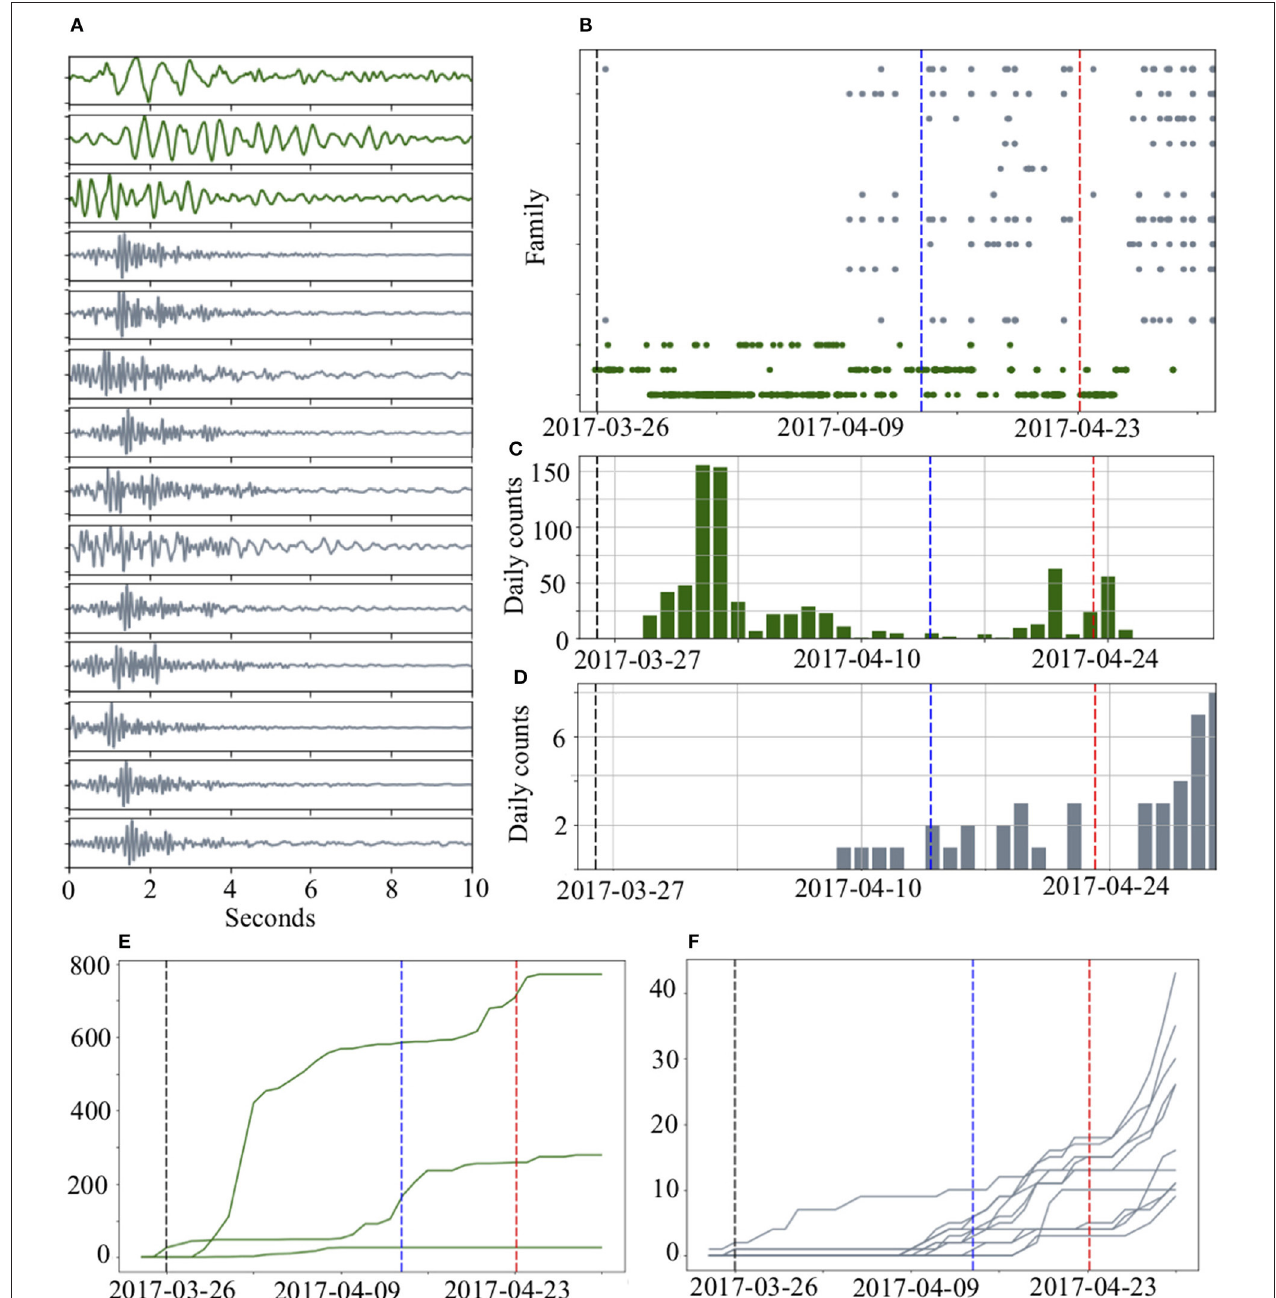
FIGURE 4 | (A) Core events (normalized) of each family identified by REDPy. VT events are shown in gray, LF events in green. (B) Duration of families, colored with respect to (A) . (C) Daily count of dominant LF family (greatest number of events) corresponding to the first waveform in (A) identified by template matching technique (EQcorrscan). (D) Daily counts of dominant VT family (greatest number of events) identified by template matching technique (EQcorrscan). (E) Cumulative counts of earthquakes within each LF family. (F) Cumulative counts of earthquakes within VT families. The dashed black line indicates the timing of increased VT activity counted by OVSICORI-UNA personnel (26 March), the dashed blue line indicates the beginning of daily phreatic eruptions (12 April), and the dashed red line indicates the timing of the large phreatomagmatic eruption (23 April).